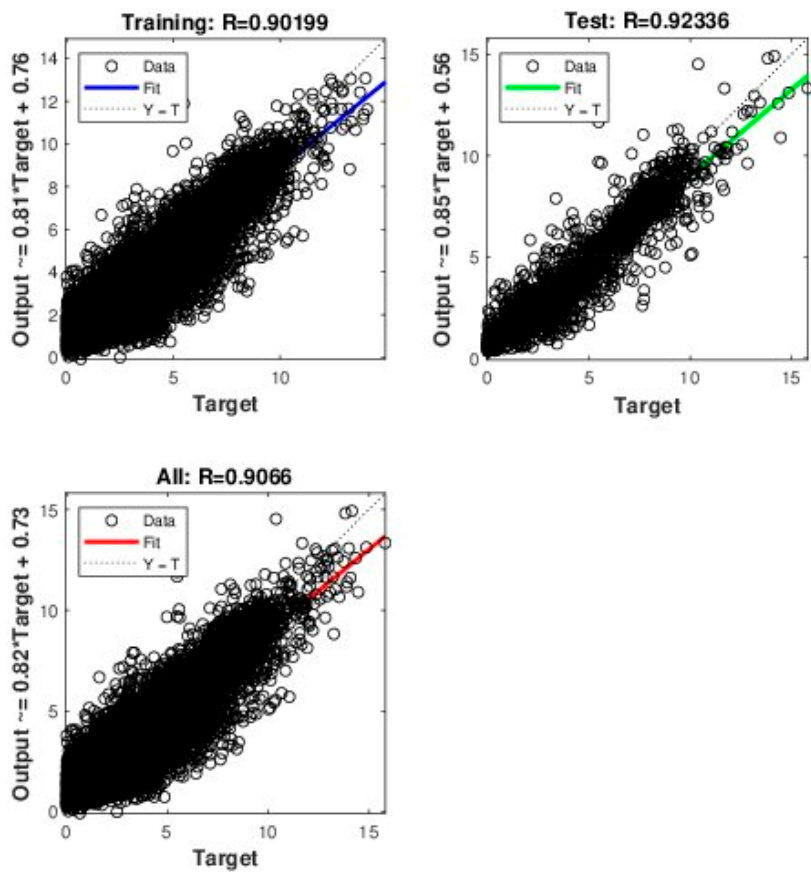
Figure 20. Regression plots of neural network (wind velocity forecasting case).